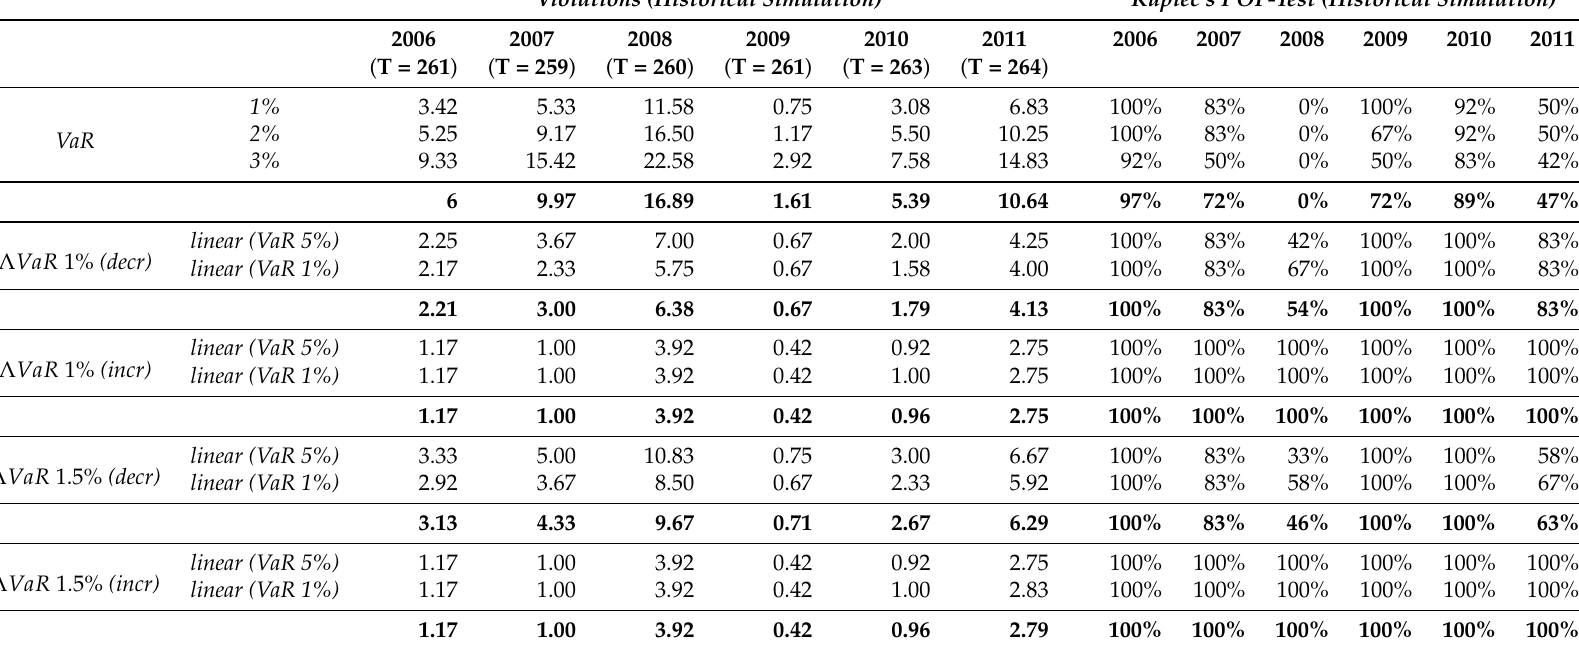
Table 1. Time evolution of the average number of violations and Kupiec test under the historical simulation assumption. The table shows the evolution over the global financial crisis of the average number of violations and the percentage of portion of failure (POF) acceptance, aggregated at the level of the VaR , as well as the increasing and decreasing Λ VaR